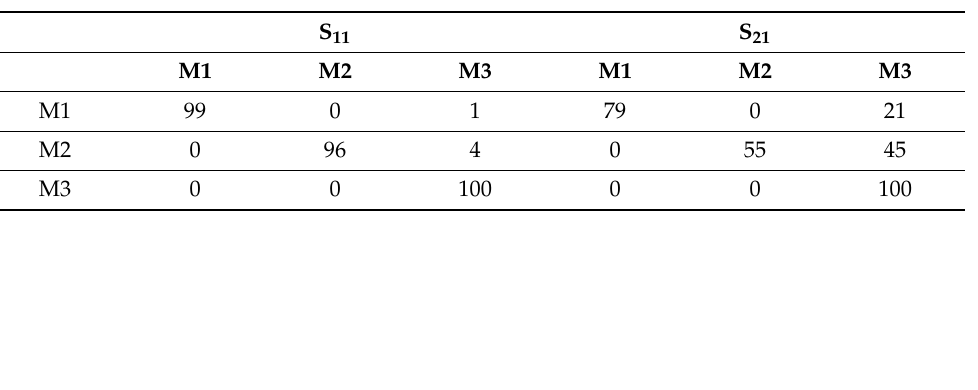
Table 4. Confusion matrix with detailed fault classification result using